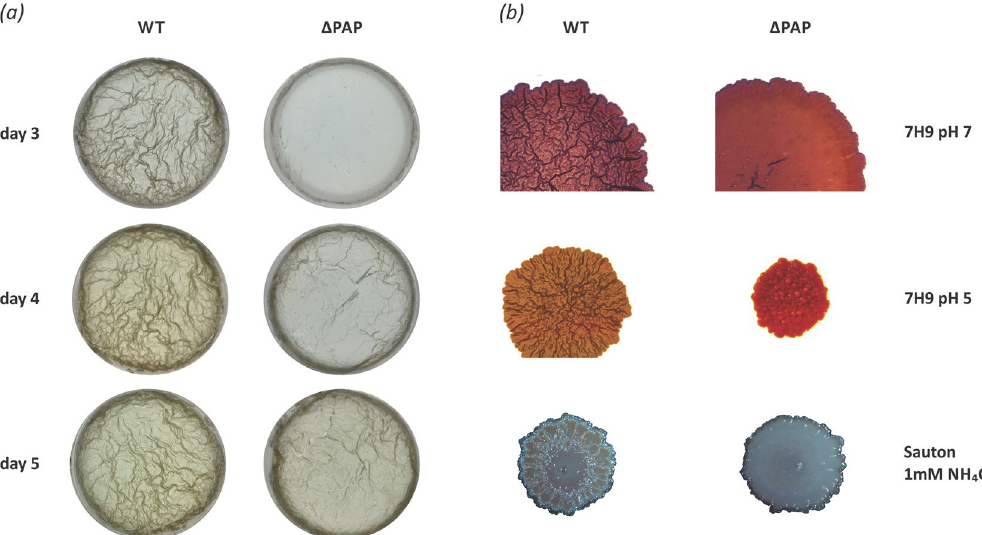
Figure 8. Analysis of biofilms formed in air–liquid interface by the WT and ΔPAP mutant strains. ( a ) WT and ∆PAP strains were incubated in Petri dishes containing a modified version of the M63 medium without shaking at 30 °C for 5 days. ( b ) Colonies of WT and ΔPAP strains grown in 7H9 medium (pH 7 and pH 5.4) and Sauton 1 mM NH 4 Cl during one week at 37° C. The images were acquired with the Olympus MVX10 magnifying glass (0,65X). WT, M. smegmatis mc 2 155 wild type strain. The results are representative of three independent biological